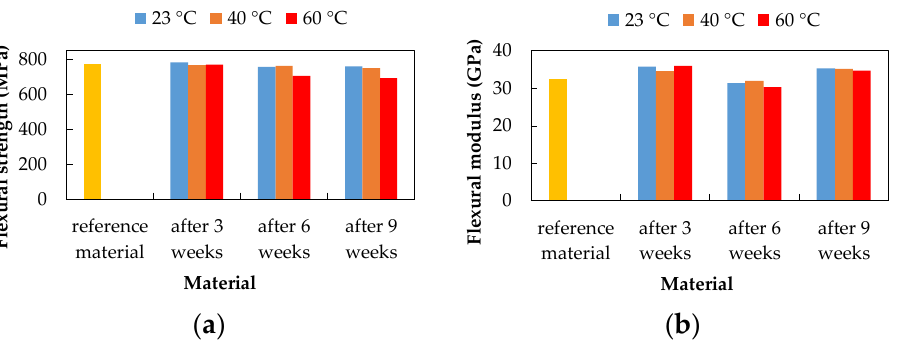
Figure 10. Influence of exposure to 15% H 2 SO 4 at different temperatures on the CFRP composite; ( a ) flexural strength; ( b ) flexural modulus.